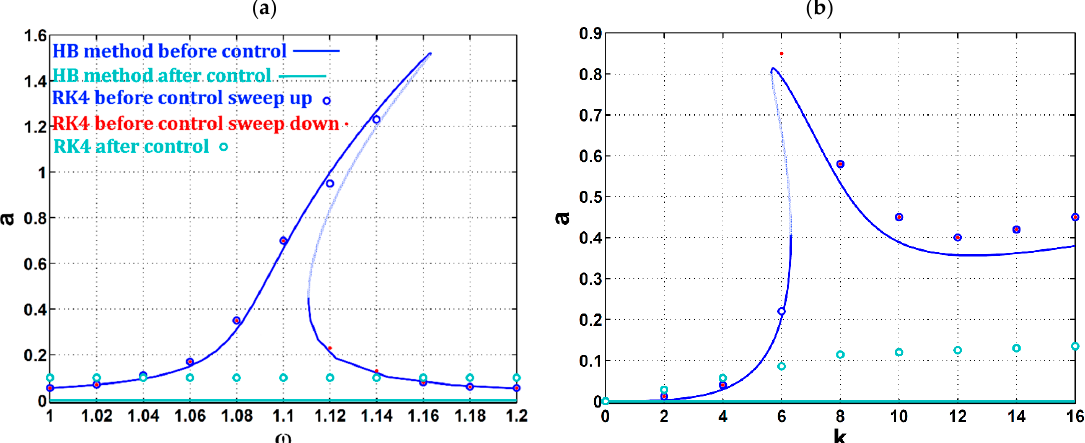
Figure 15. The time history of the car post-control ( k p = 0.8 and k v = 0.02) at ω = 1.12, k = 7, β = 0.8, and ζ = 0.02: ( a ) total trace for 600 s and ( b ) last 50 s of the total trace.